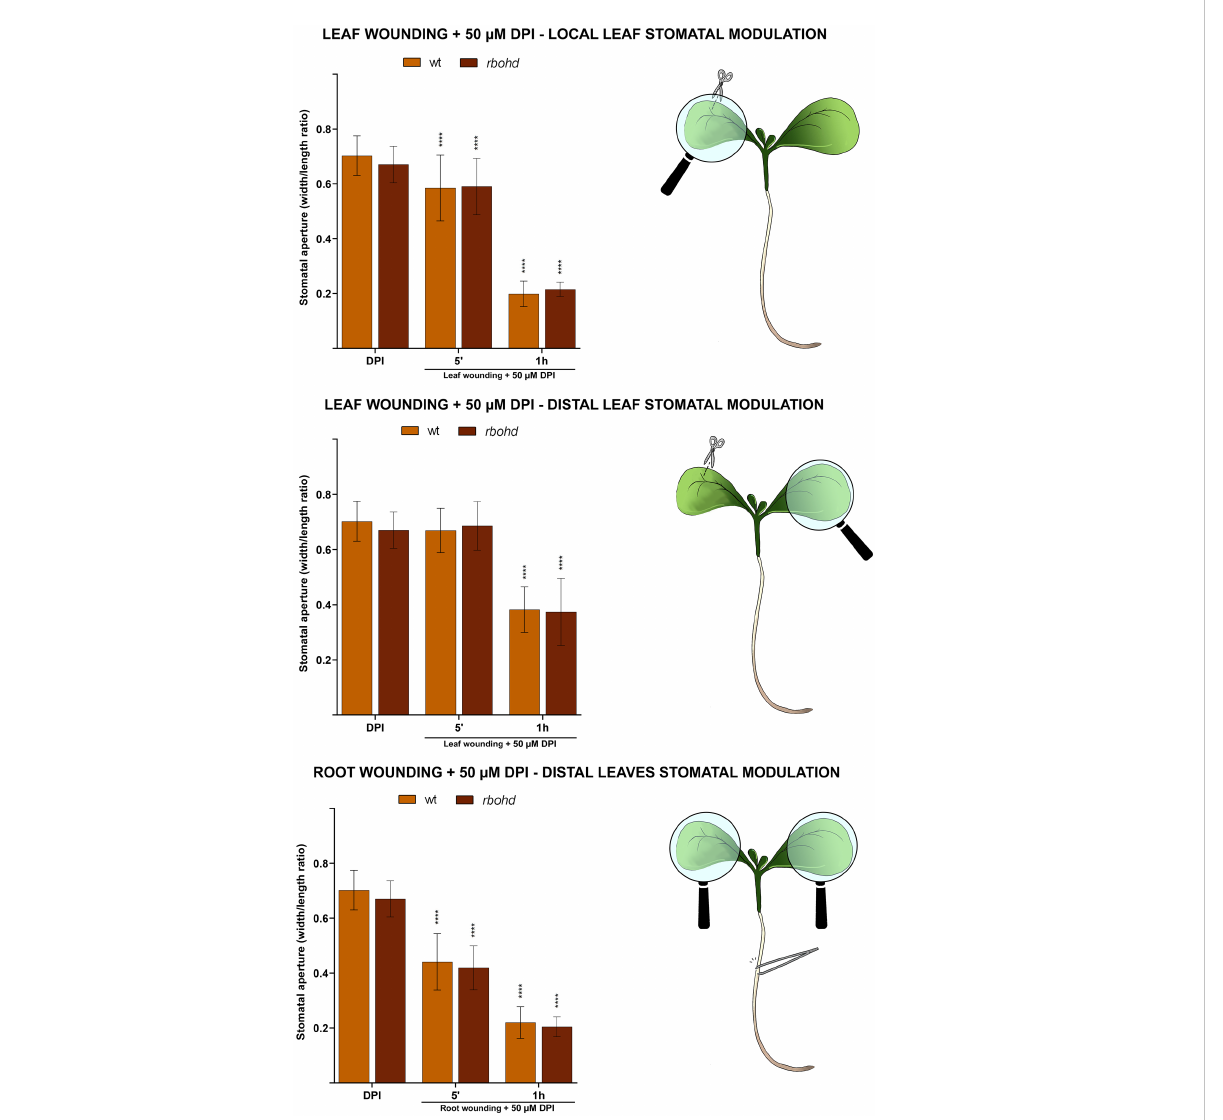
FIGURE 4 Effect of 50 m M DPI combined with cotyledonary-leaf wounding or root wounding on stomatal pore modulation of 7-day-old WT and rbohd seedlings. Cotyledonary-leaf or root was injured and seedlings were incubated in the presence of 50 m M DMTU for 5 min and 1 h. After cotyledonary-leaf wounding, analyses of stomatal pore modulation were carried out separately measuring stomata in wounded cotyledonary-leaves (local effect, top panel) and stomata in distal unwounded cotyledonary-leaves (distal effect, middle panel). After root wounding, analyses of stomatal pore modulation were carried out measuring stomata randomly chosen from both cotyledonary-leaves of each seedling (distal effect, bottom panel). Mean values ± SD ( n = 15) are reported. Signi fi cance levels between unwounded and wounded DPI-treated seedlings of each genotype are reported. p levels have been calculated with one-way ANOVA analysis; p levels > 0.05; **** p levels ≤ 0.0001. If not shown, the statistical difference is not signi fi